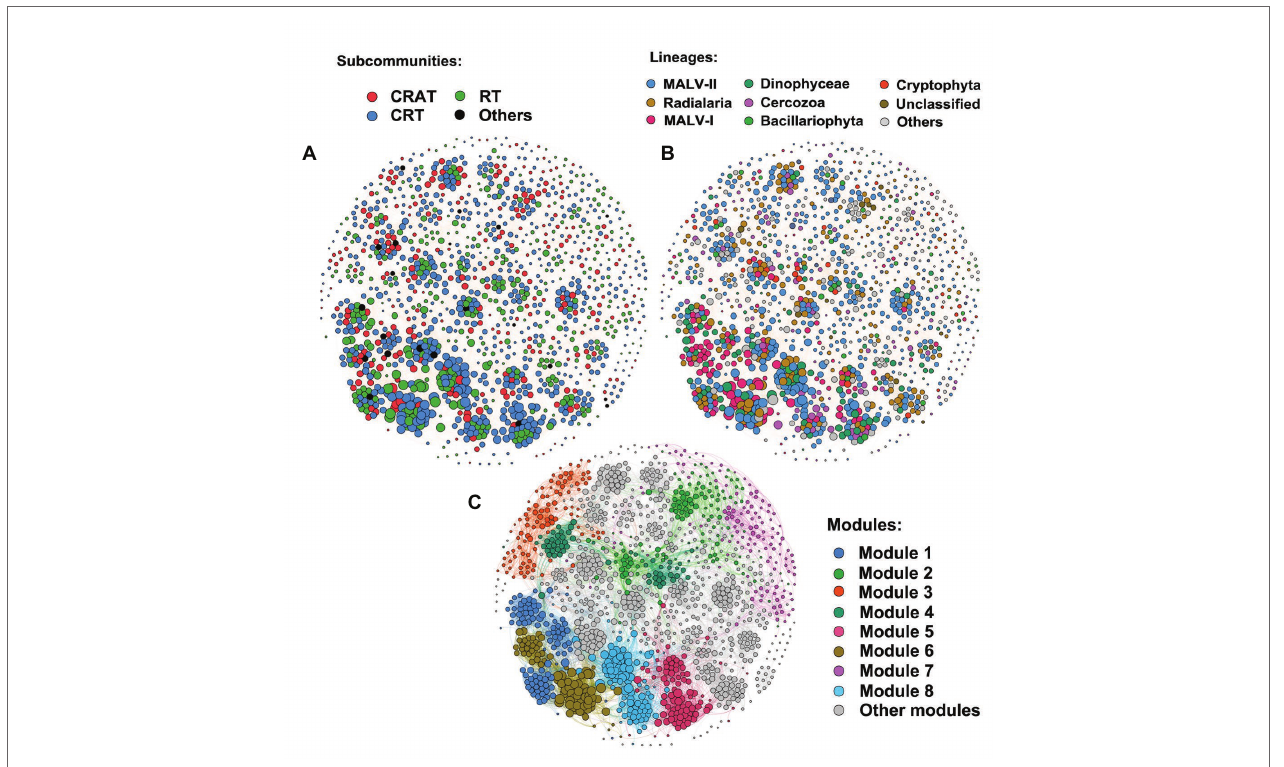
FIGURE 8 | Co-occurrence networks among OTUs of protist community. The nodes were colored according to different categories of sub-communities (A) , taxonomic lineages (B) , and modules (C) . Connections between two individual nodes stand for strong (Spearman’s r > 0.6 or r < − 0.6) and significant ( p < 0.05) correlation. The size of each node is proportional to the number of connections (i.e., degree).